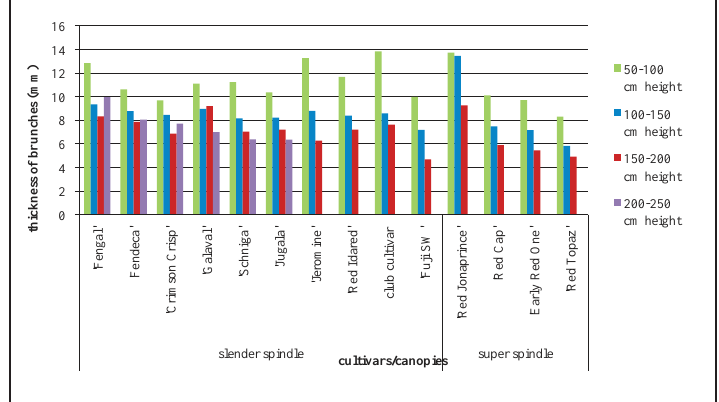
Figure 4: Thickness of the branches in different height zones of the central leader (Nyírbátor, 2014).